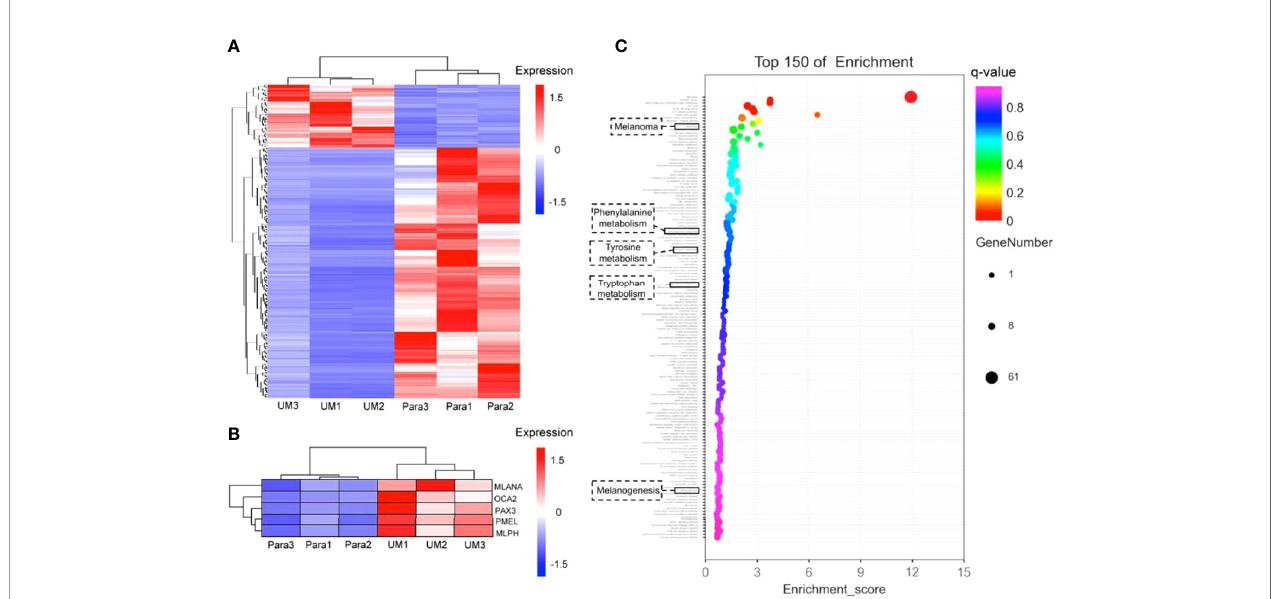
FIGURE 6 | Differential analysis of gene expression pro fi les in uveal melanoma (UM) and paracancerous tissues. (A) Cluster heatmap of total differentially expressed genes shown in heatmap graph with q value<0.05 and |log 2 Foldchange>1| in 3 UM samples and the corresponding paracancerous tissues. (B) The melanogenesis- related genes (including MLANA, OCA2, PAX3, PMEL, MLPH ) were picked from the cluster analysis in panel (A) , showing the highly expressed genes involved in melanin synthesis in UM specimens; the q values of these genes were 0.035 for MLANA , 0.013 for OCA2 , 0.013 for PAX3 , 0.027 for PMEL , and 0.021 for MLPH . (C) Gene enrichment analysis. The Y-axis in the fi gure corresponds to the functions or the pathways. The X-axis corresponds to the ratio of differential genes in a speci fi c pathway to all genes contained in the pathway; the larger the value, the higher the percentage of differential genes in the pathway. The dots on the bubble chart indicate the number of differential genes; larger dots indicate more speci fi c differential genes in the